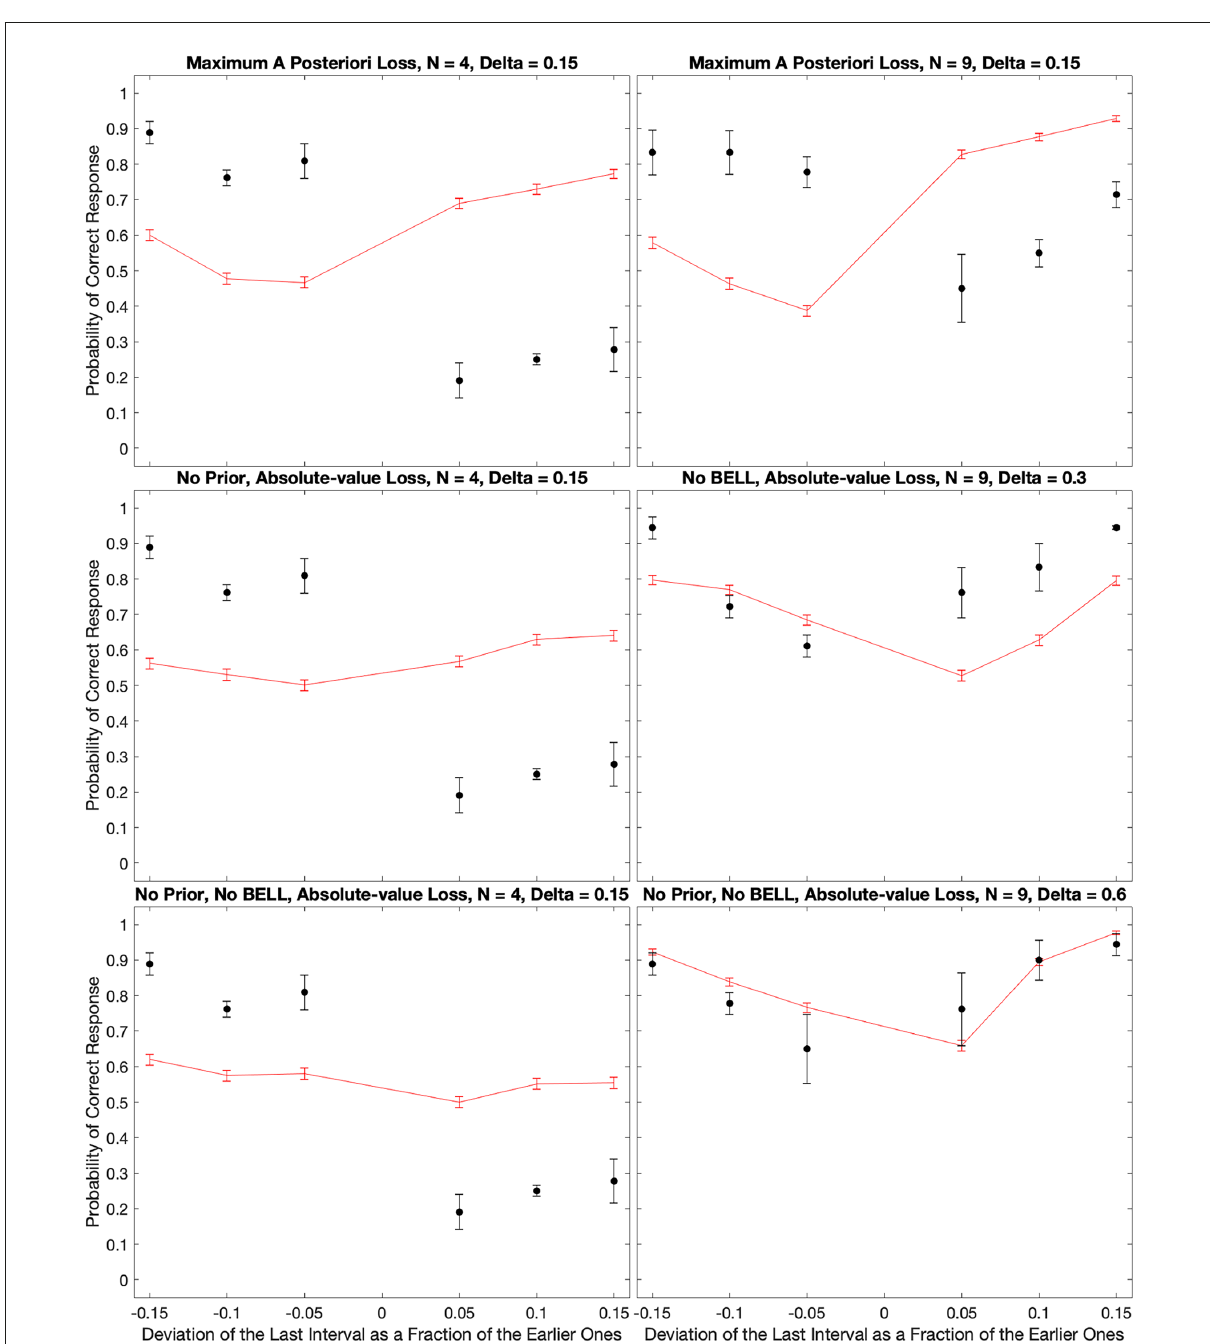
FIGURE8 Consequences of relaxing the assumption of the L 1 loss function and making the parameters less optimal. The panels illustrate what happens to the fits in Figure 7 when we use the Maximum- a-priori loss function, or when we remove the prior distribution, BELL, or both. With the Maximum- a-priori loss, the model cannot account for subjects too often responding “Early” even when the last beat comes late. The same happens when we remove the prior. Without BELL, the effect is more difficult to respond “Late” even when the last beat comes early. Finally, without prior and BELL, the only source of temporal asymmetry is in the impulse response to the beat. Although the effects are smaller, this asymmetry can capture some of both the “Early” and “Late” systematic errors.